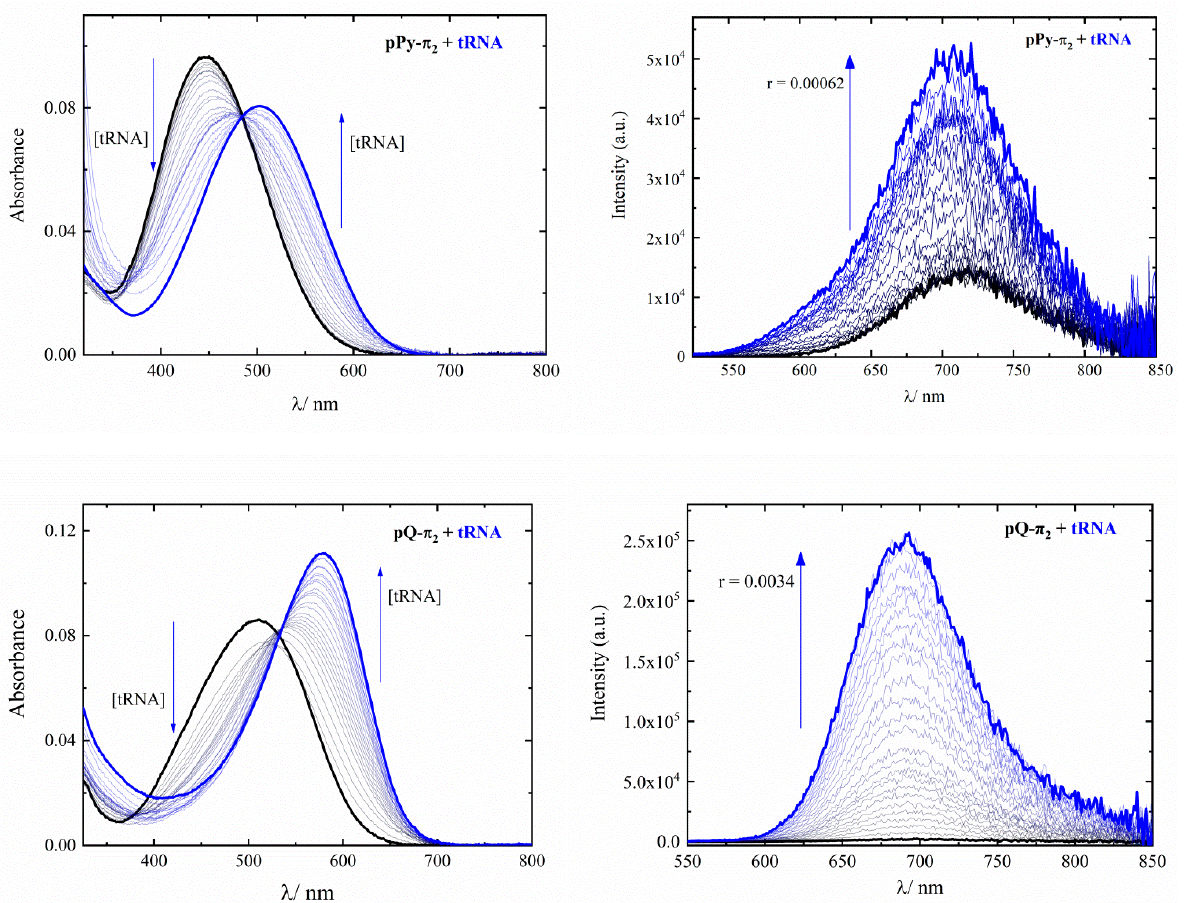
Figure 4. Changes in the absorption ( left panels ) and fluorescence ( right panels ) spectra of pPy- π 2 and pQ- π 2 in ETN buffer solution, pH 7.4, upon addition of increasing amounts of tRNA, with r = [compound]/[nucleic acid]. [ pPy- π 2 ] = 1.7 µ M, λ exc = 447 nm; [ pQ- π 2 ] = 1.5 µ M, λ exc = 510 nm. Table 3. Association constants (K ass ) of compounds pPy- π 2 and pQ- π 2 with tRNA and ct-DNA calculated by processing fluorimetric titrations through the Scatchard equation by fixing n = 0.1. n Fixed = 0.1